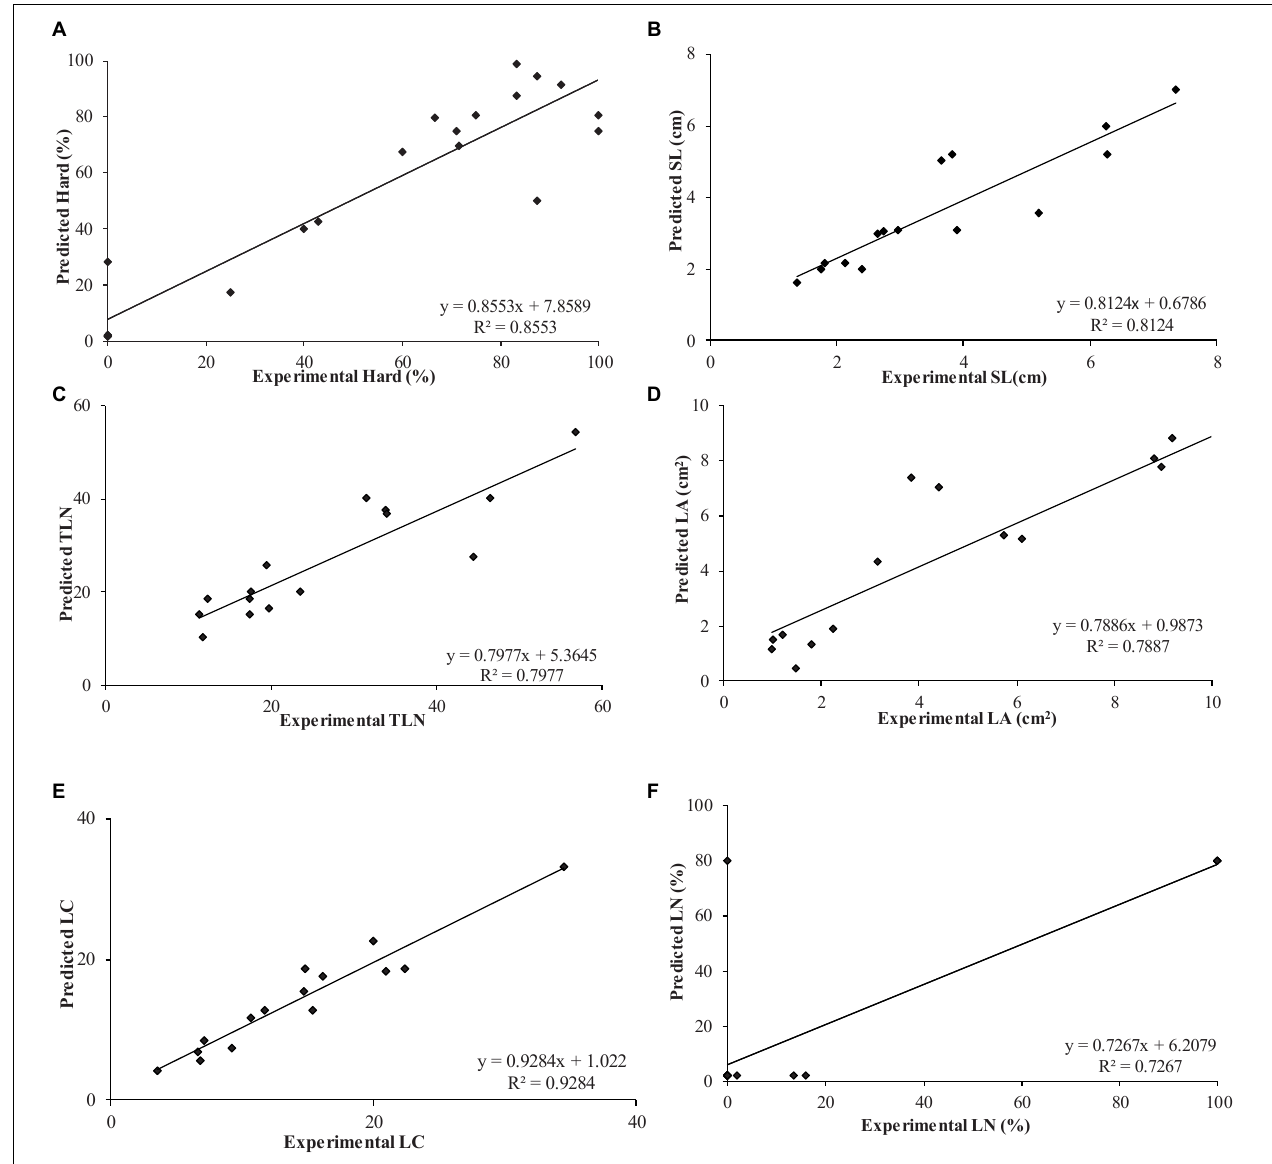
FIGURE 1 | Determination of coefficient ( R 2 ) of experimental vs. predicted values obtained by neuro-fuzzy logic models for the different parameters or outputs studied: (A) Hard, (B) SL, (C) TLN, (D) LA, (E) LCC, and (F) LN.